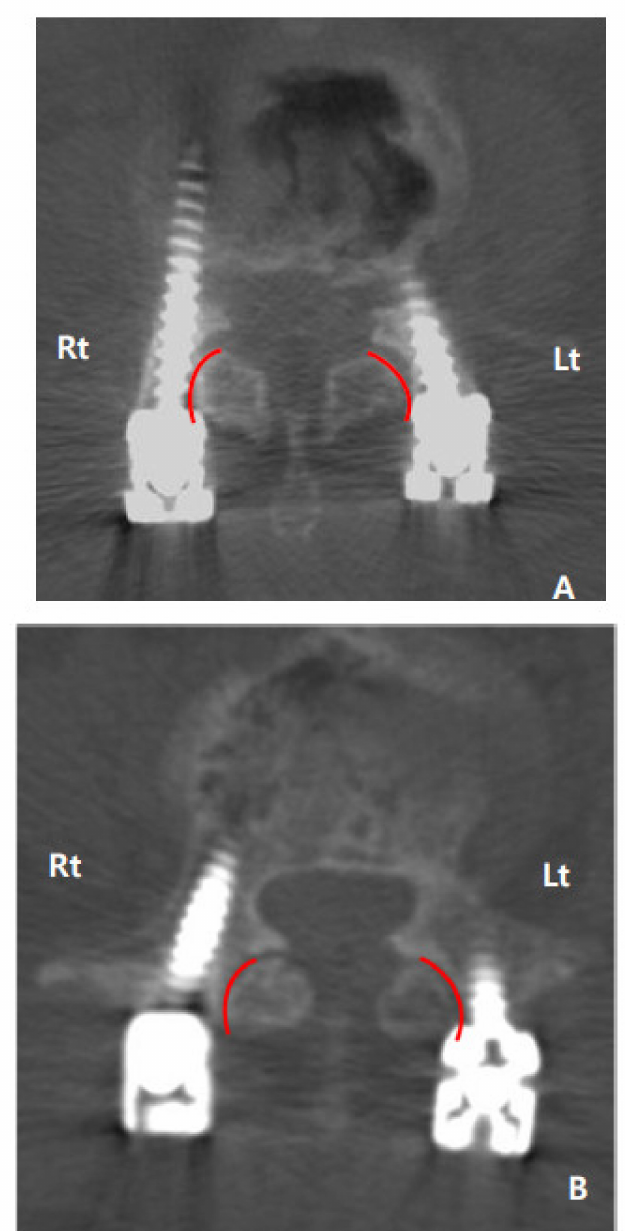
Figure 1. Superior facet joint violation by transpedicular screw evaluated using computed tomogra- phy. ( A ) The right is 2 points, the left is 1 point, and the final score is 3 points; ( B ) the right is 0 point, the left is 2 points, and the final score is 2